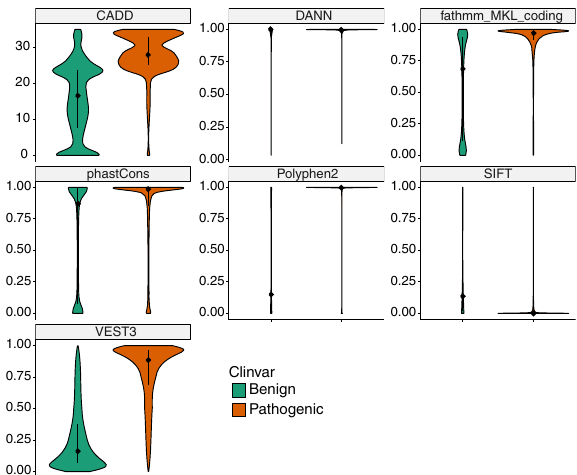
Fig. 2 Violin plots comparing scores of the selected seven variant analysis tools. All gnomAD missense variants de fi ned as patho- genic/likely pathogenic and benign/likely benign in ClinVar were evaluated. Violin plots illustrate the median value (dot) and the 25th to 75th percentile range (black line). In each plot, benign variants are on the left and pathogenic variants are on the right. The deleteriousness scores are along the y-axis. Higher values indicated a higher probability that the variant is damaging in all scores except for SIFT, where a low score is associated with deleteriousness. The y-axis for CADD is a logarithmically transformed score, and the rest are linear probabilities. The x-axis represents the probability density of variants along the range of scores. The CADD plot appears different because its y-axis is on a logarithmic instead of linear scale. Calculated mean scores with standard deviations are listed in Supplementary Dataset 4. See also Supplementary Fig.